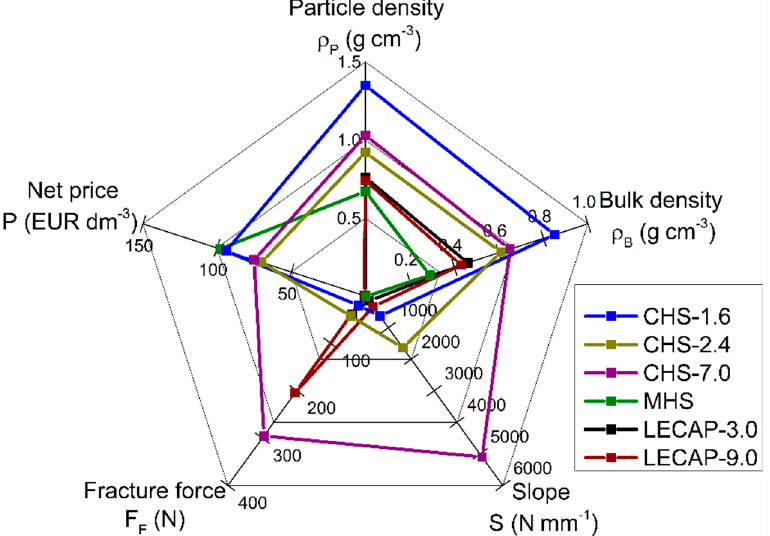
Figure 4. Radar plot of the most important properties of the investigated filler materials.